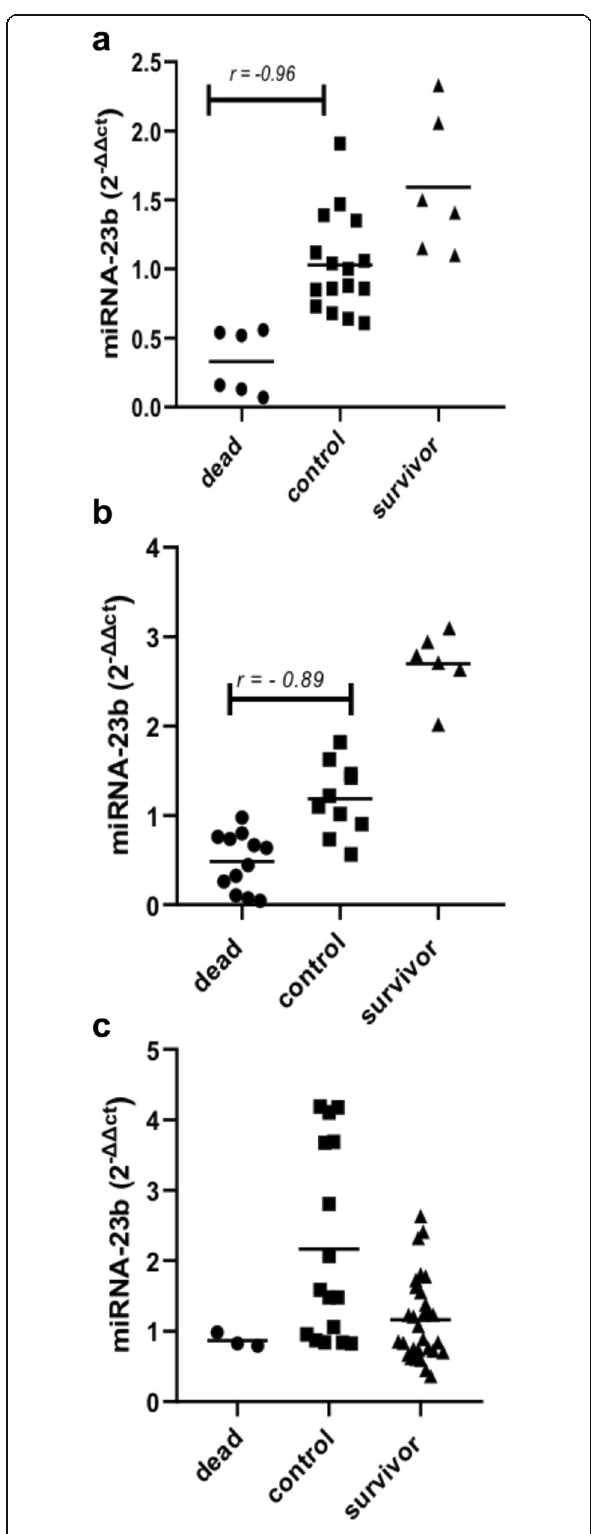
Fig. 4 Correlation between miRNA-23b expression and dead newborns with sepsis. Individual values represent the correlation with the miR-23b level, survivor and dead in newborns with sepsis. a : in early onset sepsis in at-term newborns, b : early onset sepsis in premature newborns, c : late onset sepsis in at-term newborns. Control: patients with negative haemoculture, dead: dead patients with sepsis, survivor: survivor patients with sepsis, r